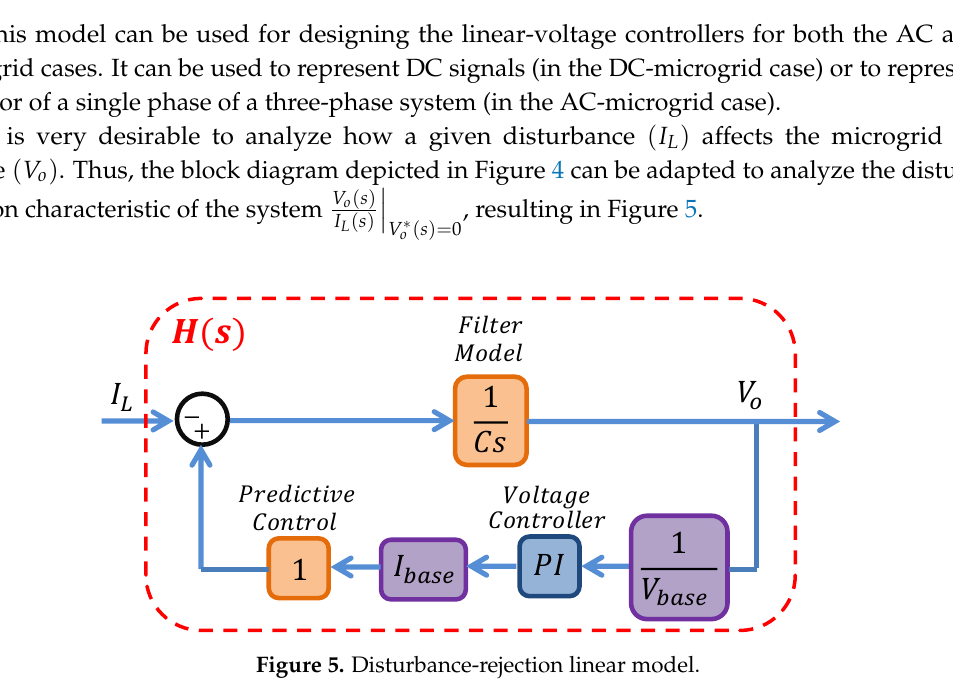
Figure 4. Reference-tracking linear model.